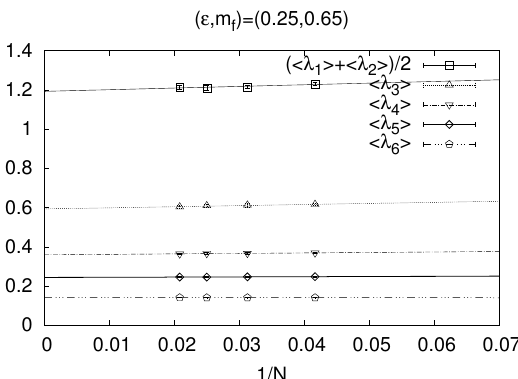
Figure 3 . The expectation values h (cid:21) (cid:22) i are plotted against 1 =N for " = 0 : 25 and m f = 0 : 65 with N = 24 ; 32 ; 40 ; 48. For h (cid:21) 1 i and h (cid:21) 2 i , we plot their average to increase the statistics. The straight lines represent (cid:12)ts to a + b=N , which enable us to make reliable extrapolations to N = 1 . ( "; m ) as well. Thus we can make extrapolations to N = 1 reliably. Let us denote the f extrapolated values obtained for each ( "; m